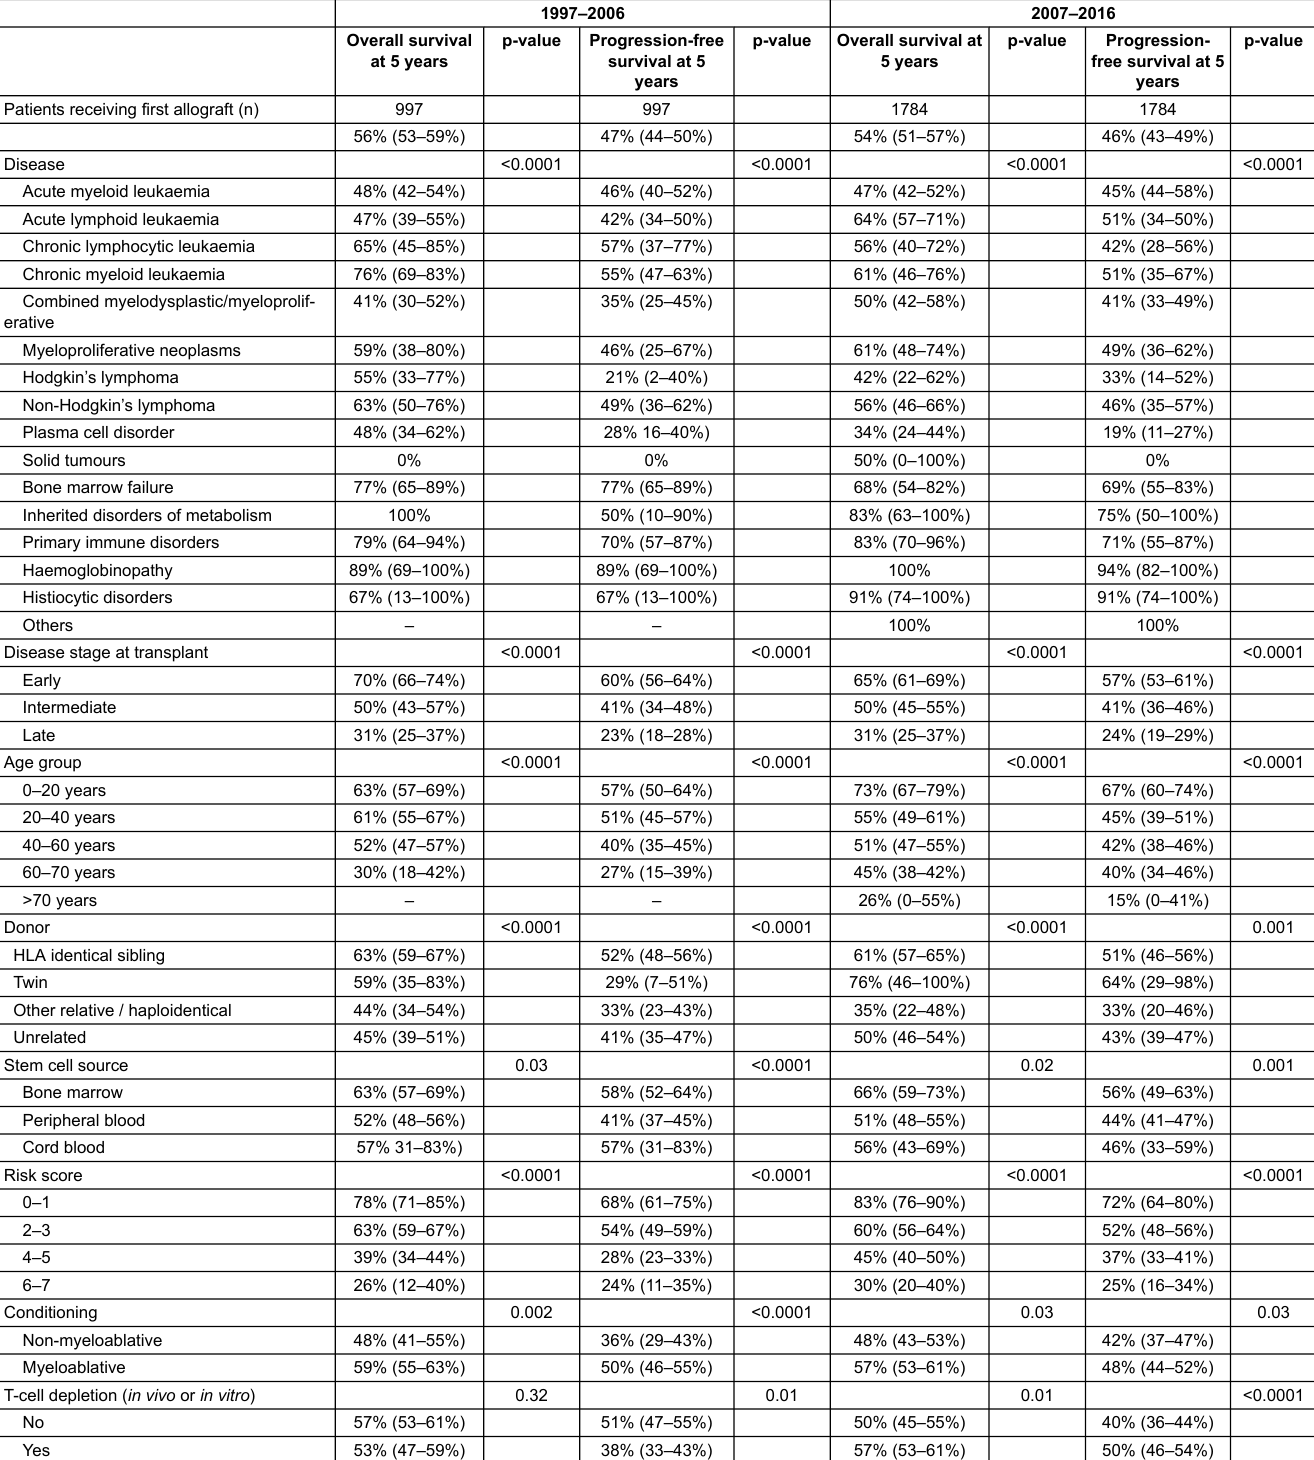
Table 2: a: Univariate analysis of overall and progression-free survival for allogeneic haematopoietic cell transplants by decade for the years